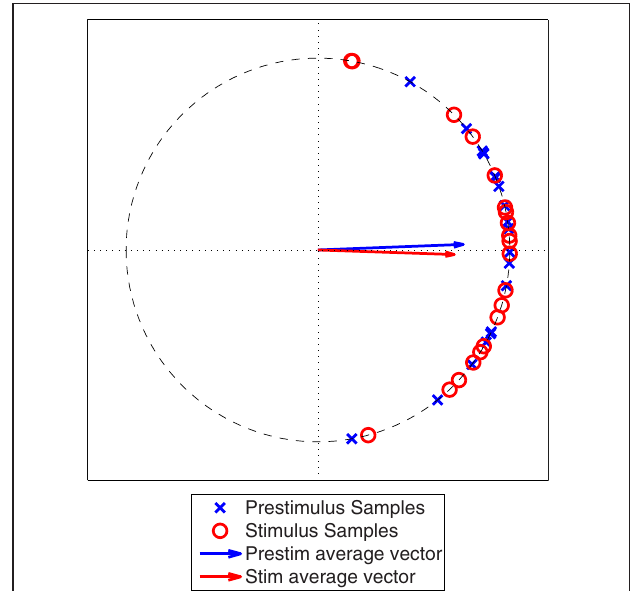
FIGURE 4 | Simulated phase angle differences for a poststimulus period (Stim) and a prestimulus period (Prestim), both generated from a von Mises distribution with θ equal to zero and κ equal to 4. The vectors represent the vector averages of the data points corresponding to each population of phase angle